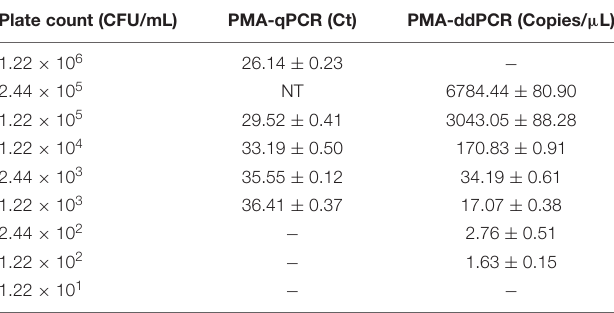
TABLE 4 | Comparison of detection results of PMA-qPCR and PMA-ddPCR in spiked plasma samples. Plate count (CFU/mL) PMA-qPCR